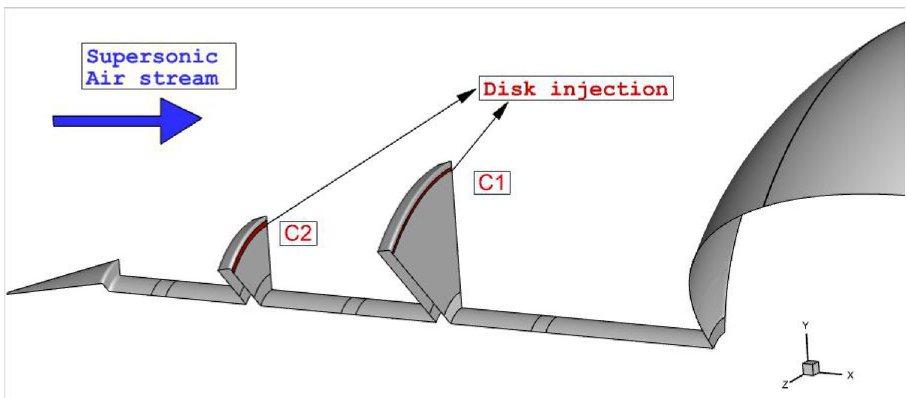
Figure 1. Selected model with proposed injection